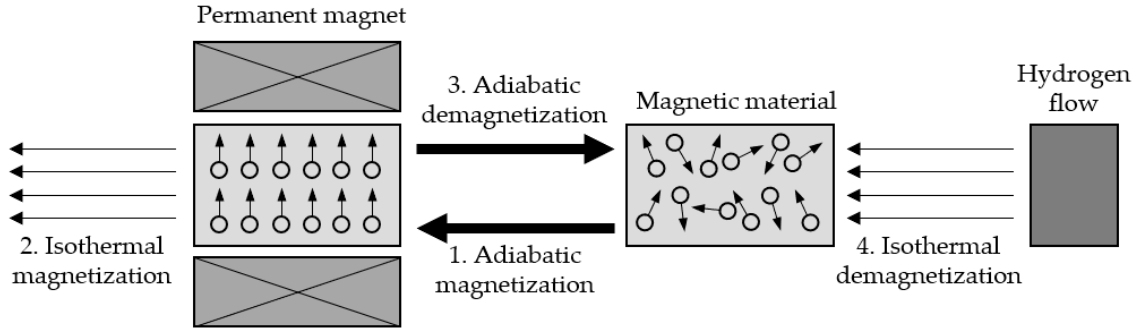
Figure 9. Schematic diagram of magnetic hydrogen liquefaction.